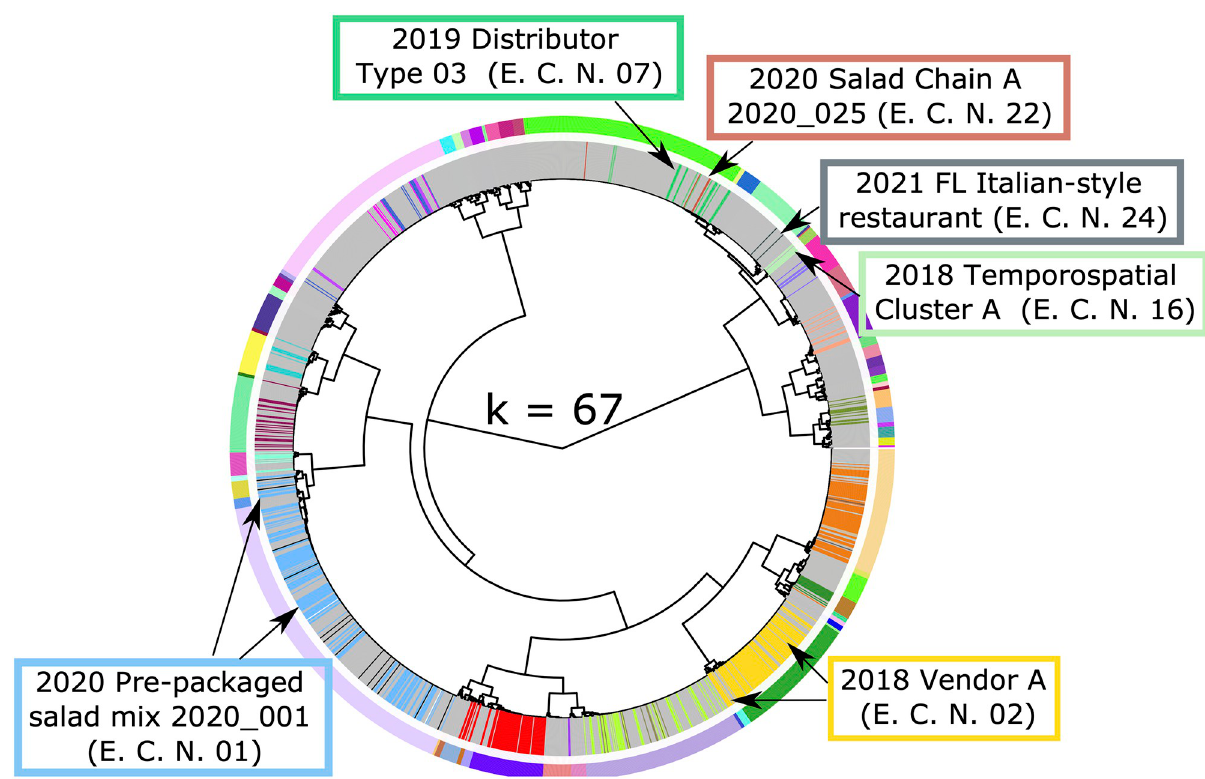
Fig 3. Impact of maximum stringency ( s ) value on genetic linking of epidemiologically-linked isolates. The hierarchical tree generated from our distance matrix was dissected into the optimal value of k ( k = 67) predicted using the 99.5% s -value. The outer circle of colored bars indicates the boundary between each partition predicted and the inner circle of colored bars represents the epidemiologic linkage of various isolates, where each bar color represents a distinct epidemiologic cluster (grey represents isolates of unknown epidemiologic linkage). Epidemiological clusters of interest are labeled in the colored boxes. (A) At k = 99.5%, we observe that the labeled epidemiologic clusters on the bottom of the tree have isolates split across multiple genetic partitions, suggesting that the maximum stringency value is unnecessarily splitting epidemiologic clusters between partitions.